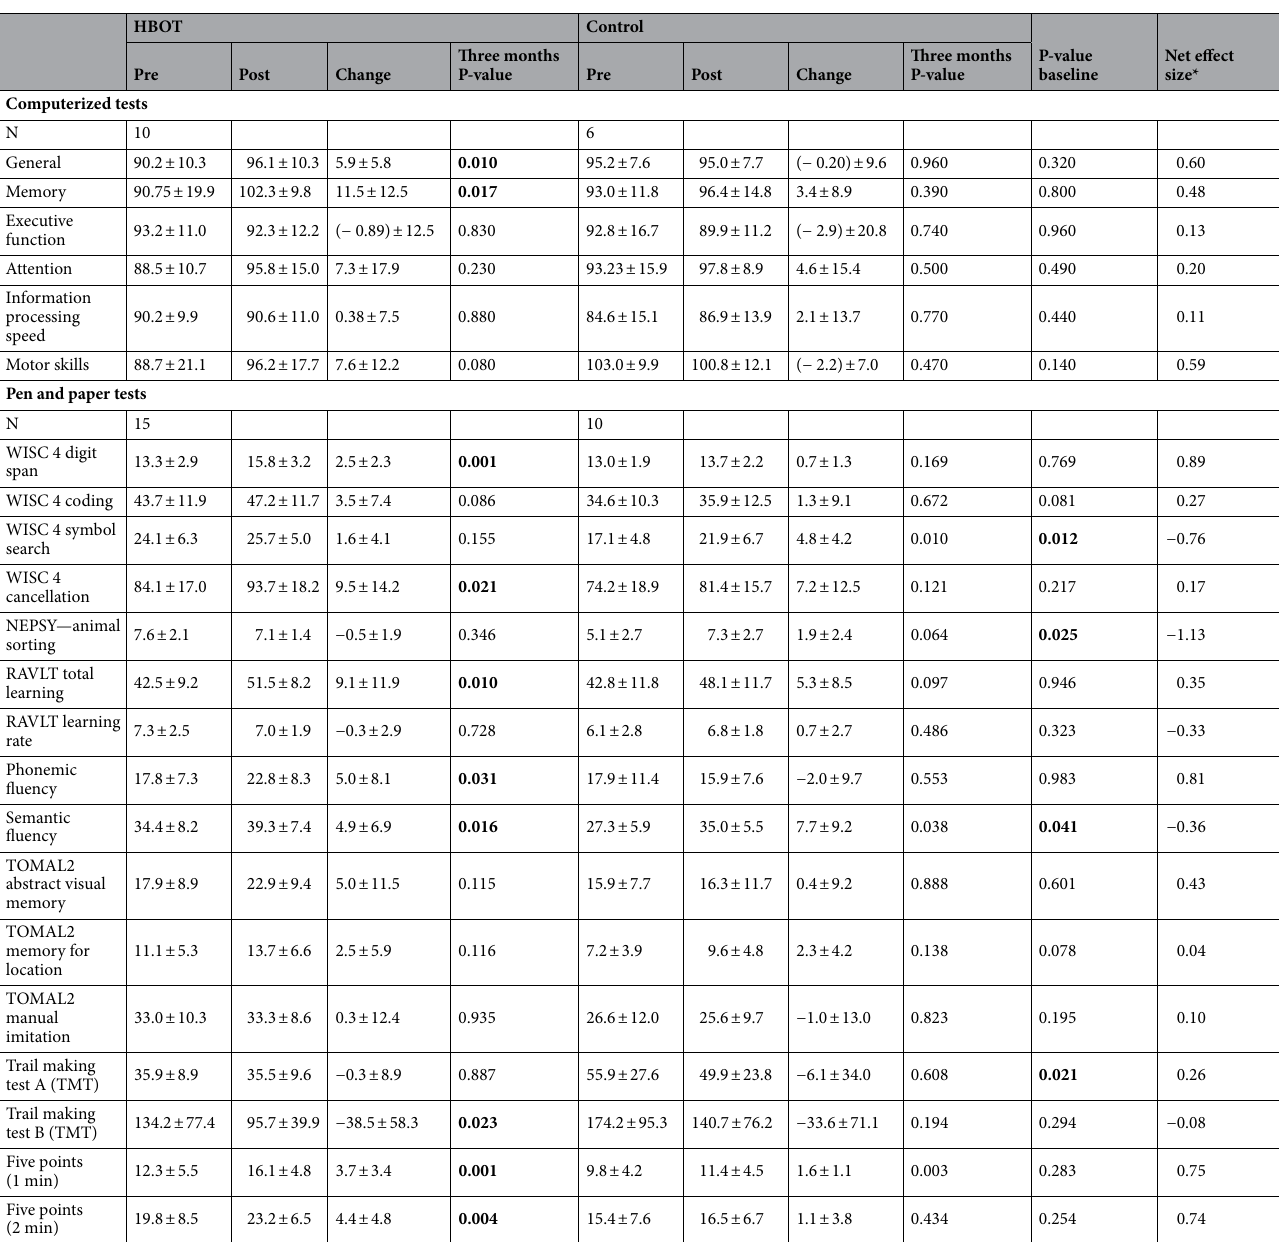
Table 2. Cognitive function changes. Baseline comparison of p-values test the null hypothesis of equal means of the two groups at the baseline using an unpaired t-test; three months comparison of p-values test the null hypothesis of equal means of each group pre-post intervention (HBOT/sham respectively) using a paired t-test; bold, P < 0.05, Net effect size is the subtraction of Cohen’s D effect size of the control group from the HBOT group Cohen’s D effect size; Neurotrax scores are normalized to